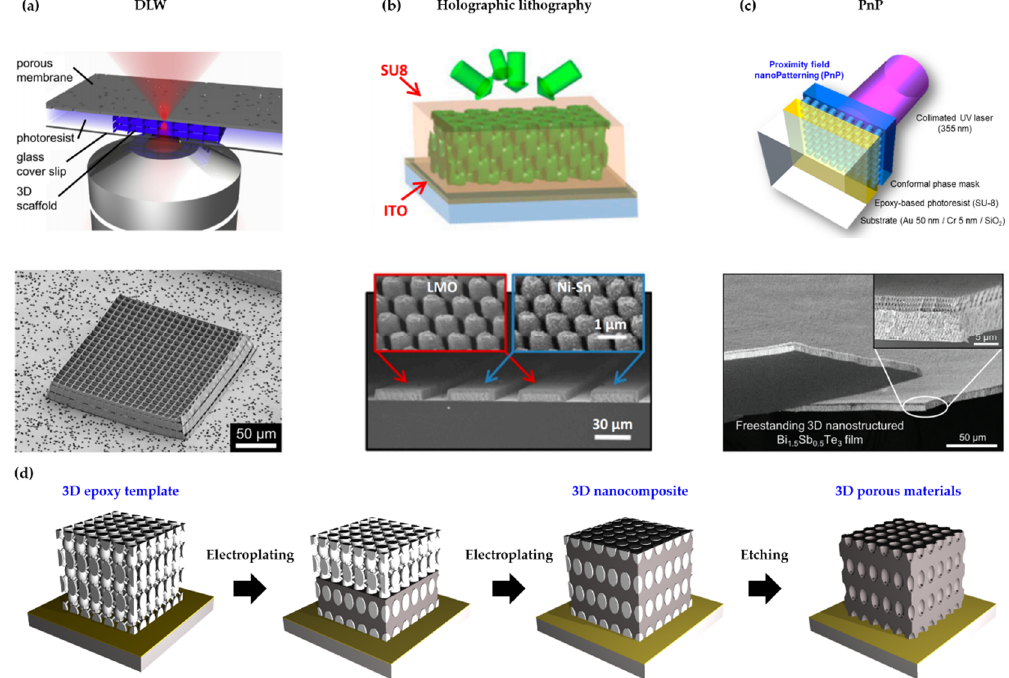
Figure 1. ( a ) Schematic illustration (top) and SEM image (bottom) of a 3D scaffold synthesized by DLW (direct laser writing) (reprinted with permission from [21]. Copyright 2014 Elsevier); ( b